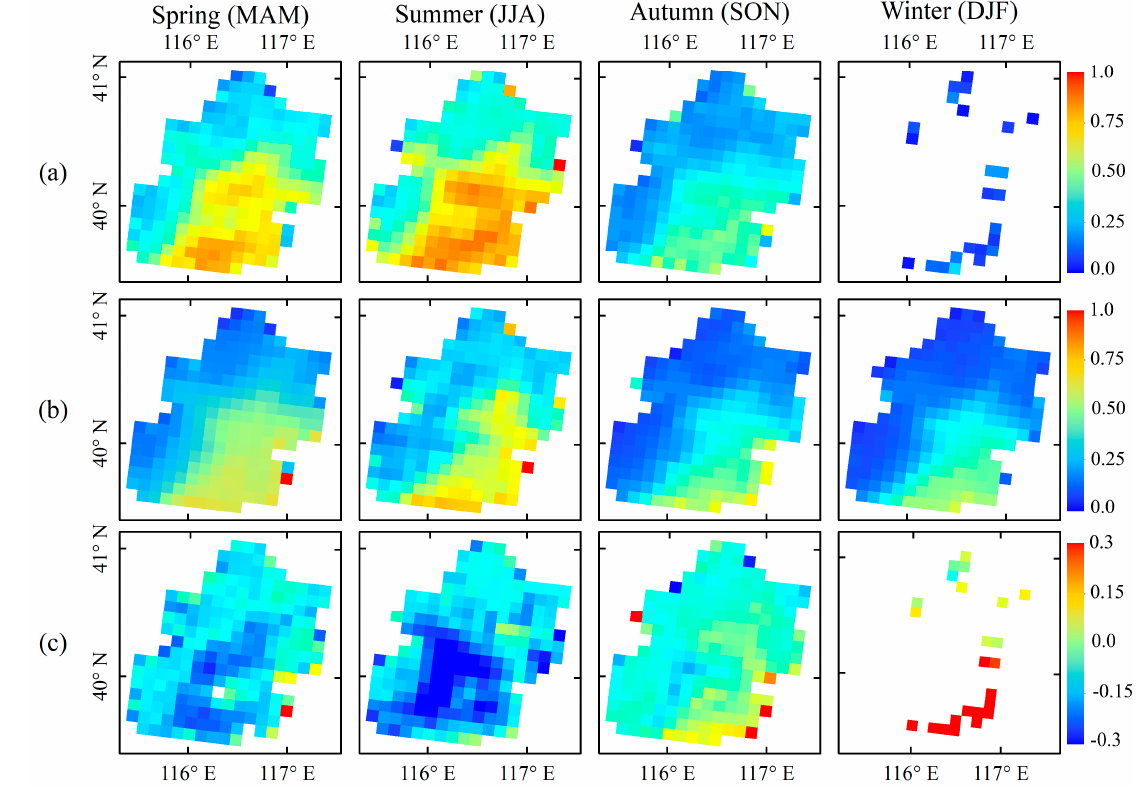
Figure 4. Seasonal mean distributions of AOD from July 2002 to December 2016, at 10 km, for ( a ) MODIS-Aqua C6.1 DT and ( b ) MODIS-Aqua C6.1 DB; and ( c ) the seasonal mean differences (DB–DT AOD) between the DT and DB